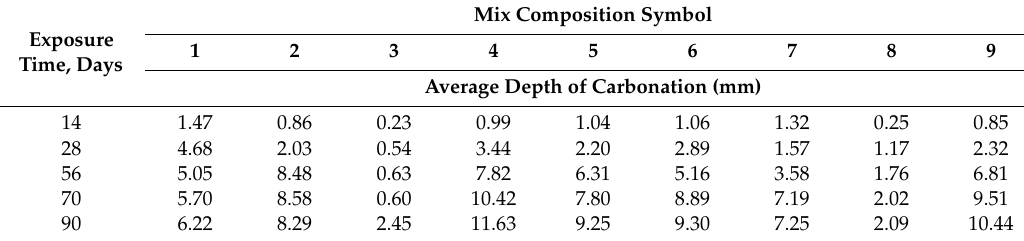
Table 8. Average values of measured depths of